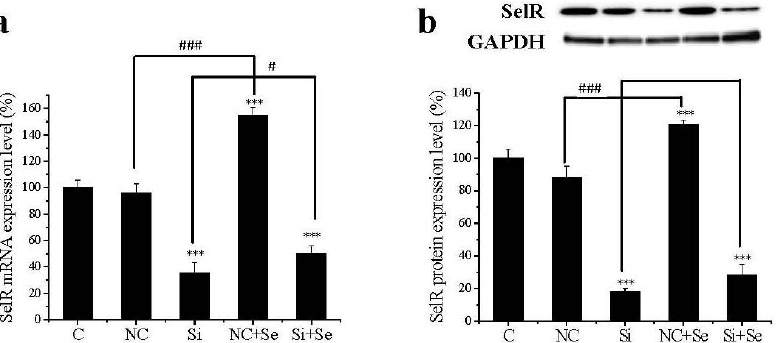
Figure 1. The efficiency of Selenoprotein R ( SelR ) gene knockdown in human lens epithelial (hLE) cells. SelR mRNA ( a ) and protein levels ( b ) in hLE cells were assayed by Real-time PCR and western blot using GAPDH as a reference. Data are the mean ± SD of at least three independent experiments. *** p < 0.001, compared to control group; # p < 0.05, ### p < 0.001. C: control cells; NC: negative control celle; Si: SelR siRNA cells; NC+Se: negative control cells exposed to Na 2 SeO 3 (1 μM) for 36 h; Si+Se: SelR siRNA cells exposed to Na 2 SeO 3 (1 μM) for 36 h.